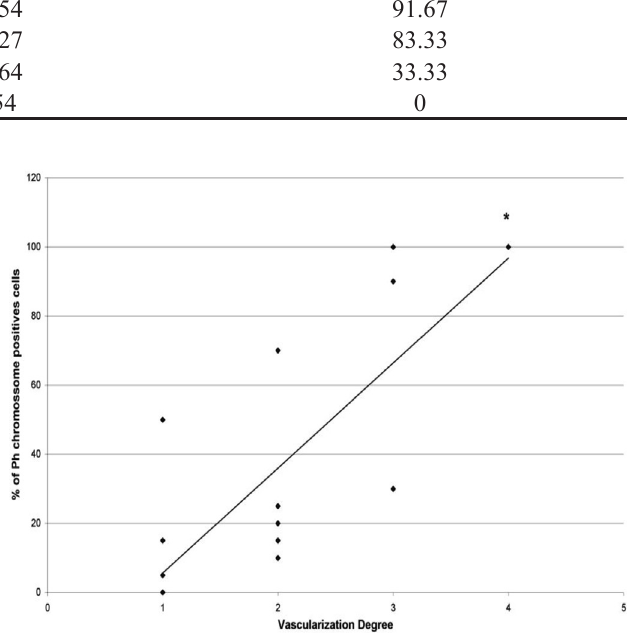
TABLE VI - Relationship between Vascularization degree of BMB from CML patients collected after IM treatment and CR Vascularization degree of BMB (after 6 to 12 months of IM treatment)